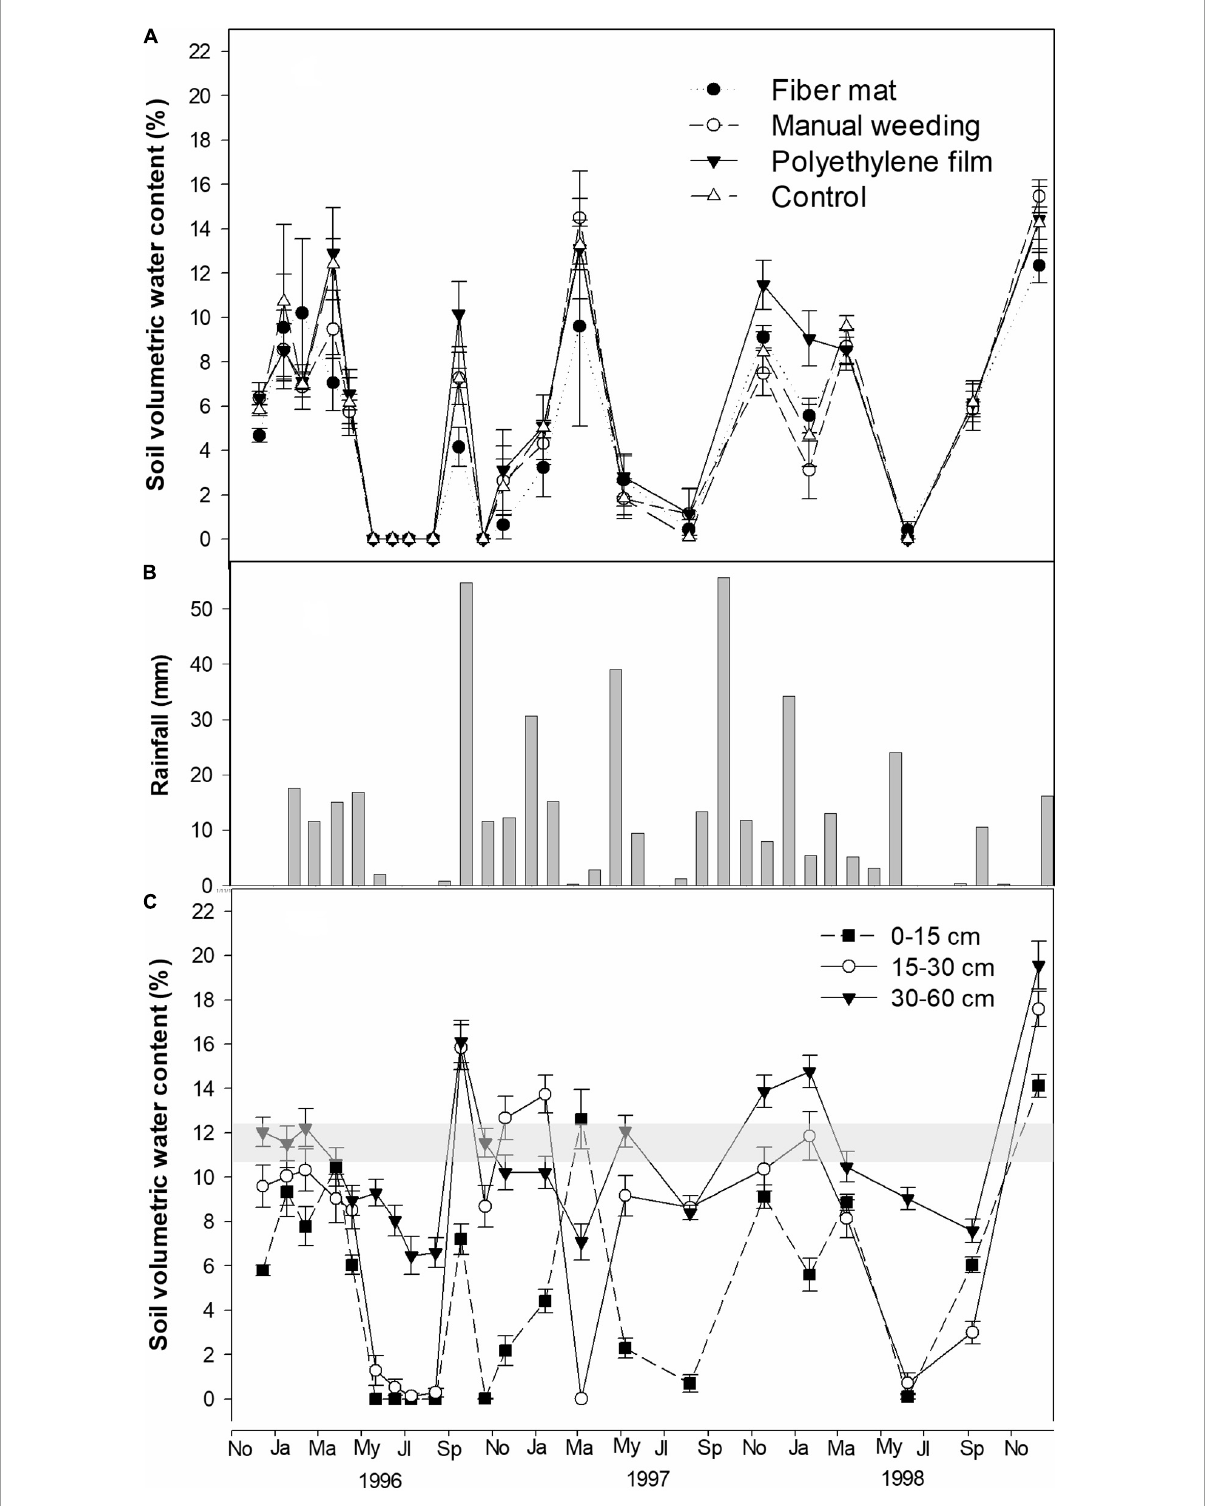
FIGURE1 Soil volumetric water content ± SE (VWC) and rainfall during the first 3 years of the study period (from planting in November 1995 to the end of 1998): (A) VWC at 0–15 cm as affected by competition suppression treatments ( n = 5); (B) monthly rainfall (mm); (C) VWC at three depths averaged by treatments ( n = 20). In sub-figure (C) wilting point range is shaded (see section “Materials and methods” for details).